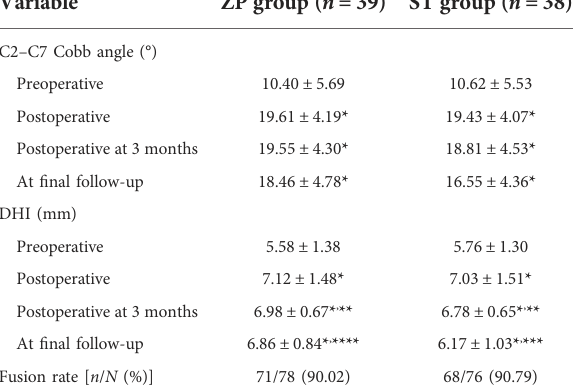
TABLE 4 Patients ’ radiological outcomes.